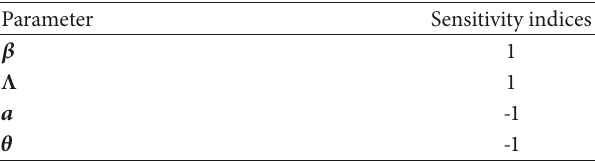
Table 2: The sensitivity indices of 𝑅 01 .